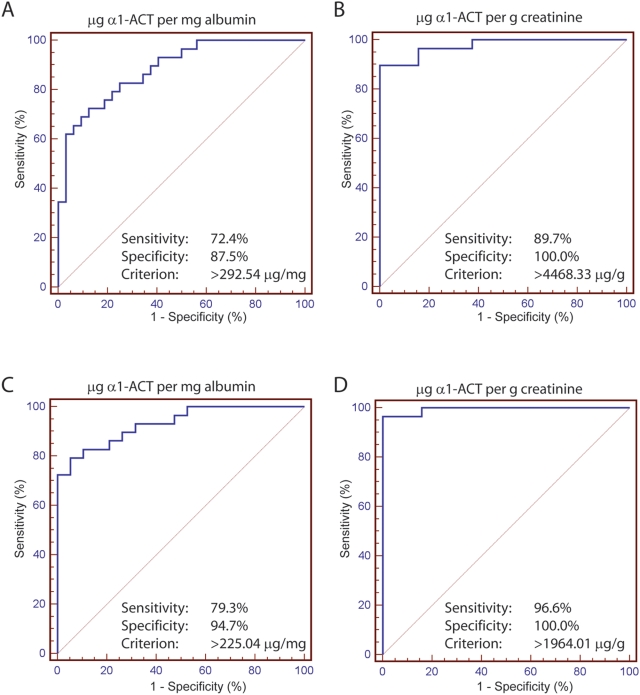
Receiver Operating Characteristic (ROC) Curve Analysis.ROC curves were calculated for µg α1-ACT/mg albumin (a & c) or µg α1-ACT/mg creatinine (b & d) for sCJD patients relative to either Control group A and AD patients (a & b) or Control group A, AD and Control C patients (b & d). Sensitivity, specificity, and threshold (criterion) for each are indicated.